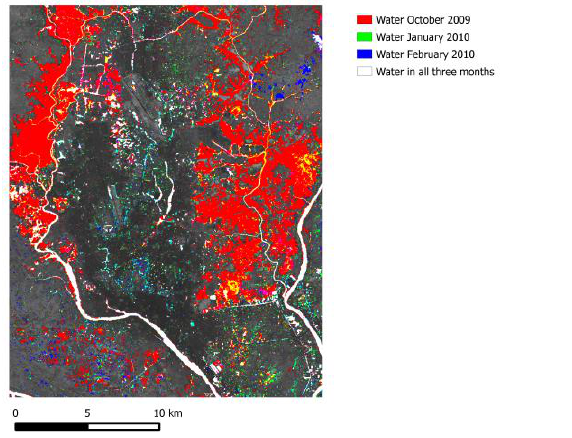
Figure 13. Overlapping of Water